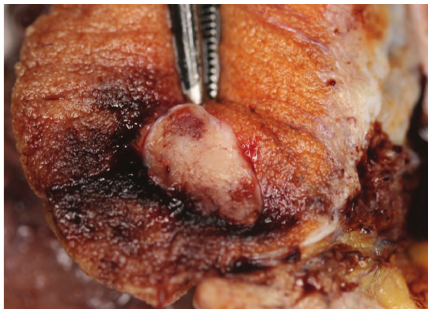
Figure 3: Vascular testicular tumor, measuring 12mm in diameter.